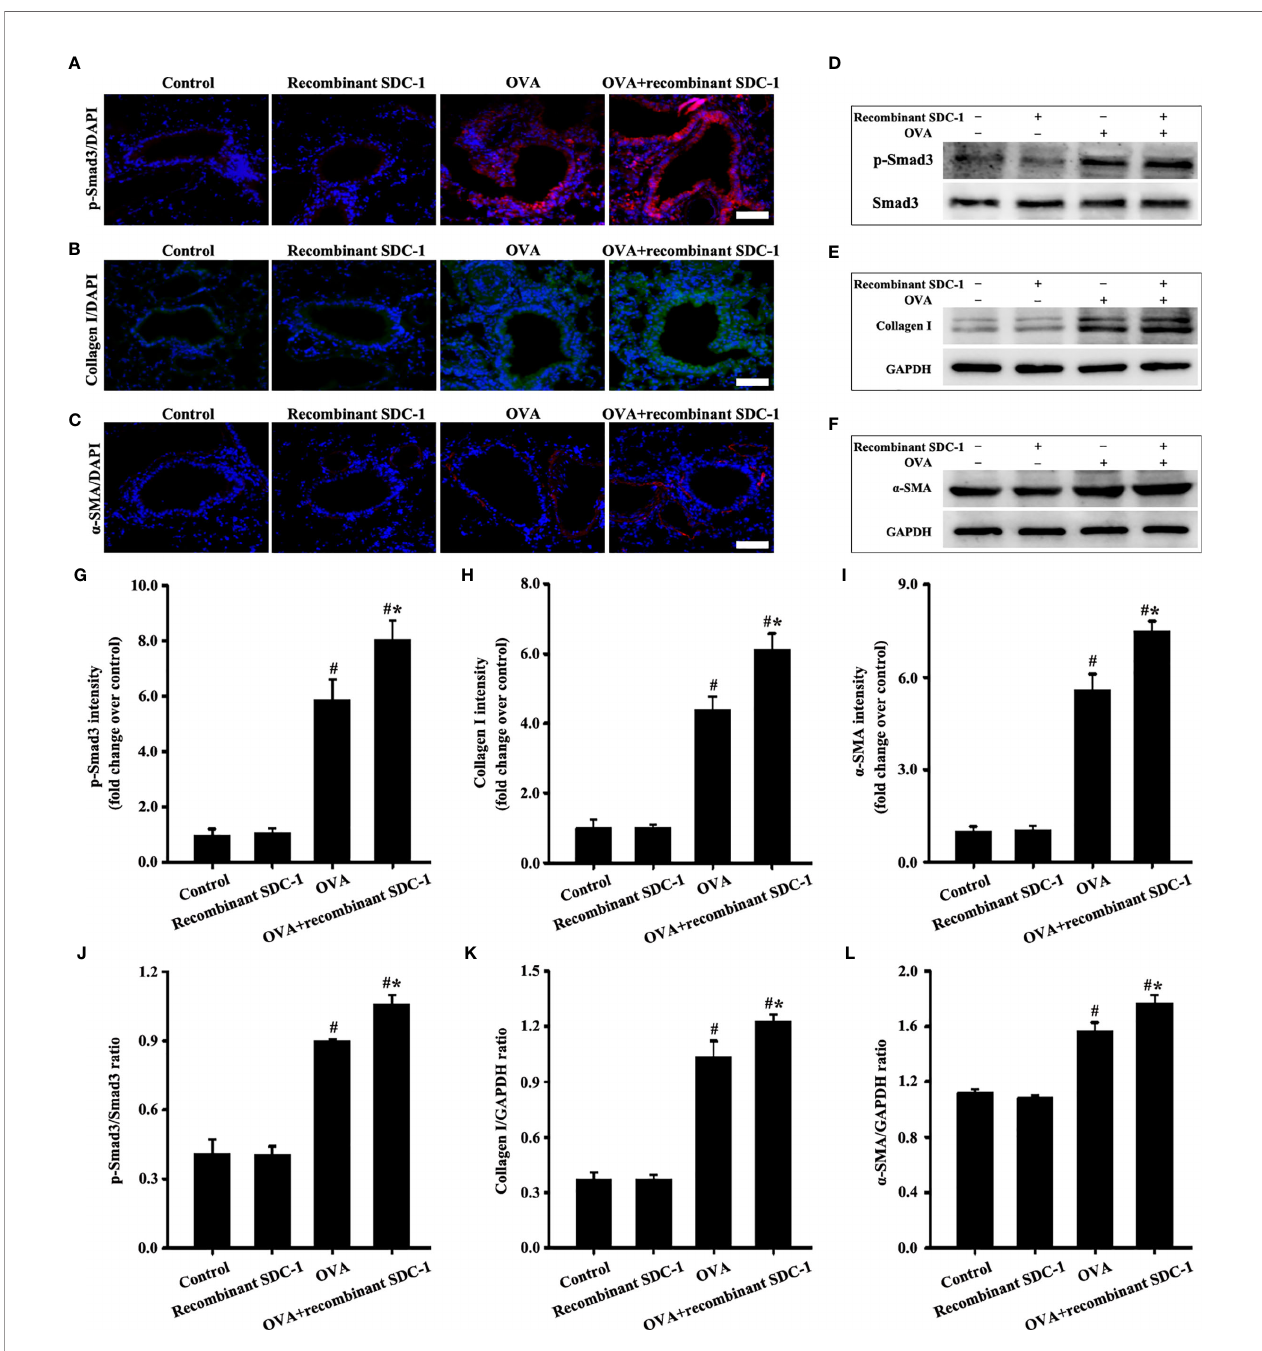
FIGURE 10 | Animal experimental intervention schedule is shown in Figures 8A1, A3 . Effects of inhalation with the recombinant mouse SDC-1 protein on the levels of p-Smad3 (A , D) , collagen I (B , E) , and a -SMA (C , F) in mice were observed. (G – I) Immuno fl uorescence intensity analysis of A – C) , respectively. (J – L) Gray intensity analysis of (D – F) , respectively. Data are shown as the means ± SD of three independent experiments. # p < 0.05 versus the control group. # *p < 0.05 versus the OVA